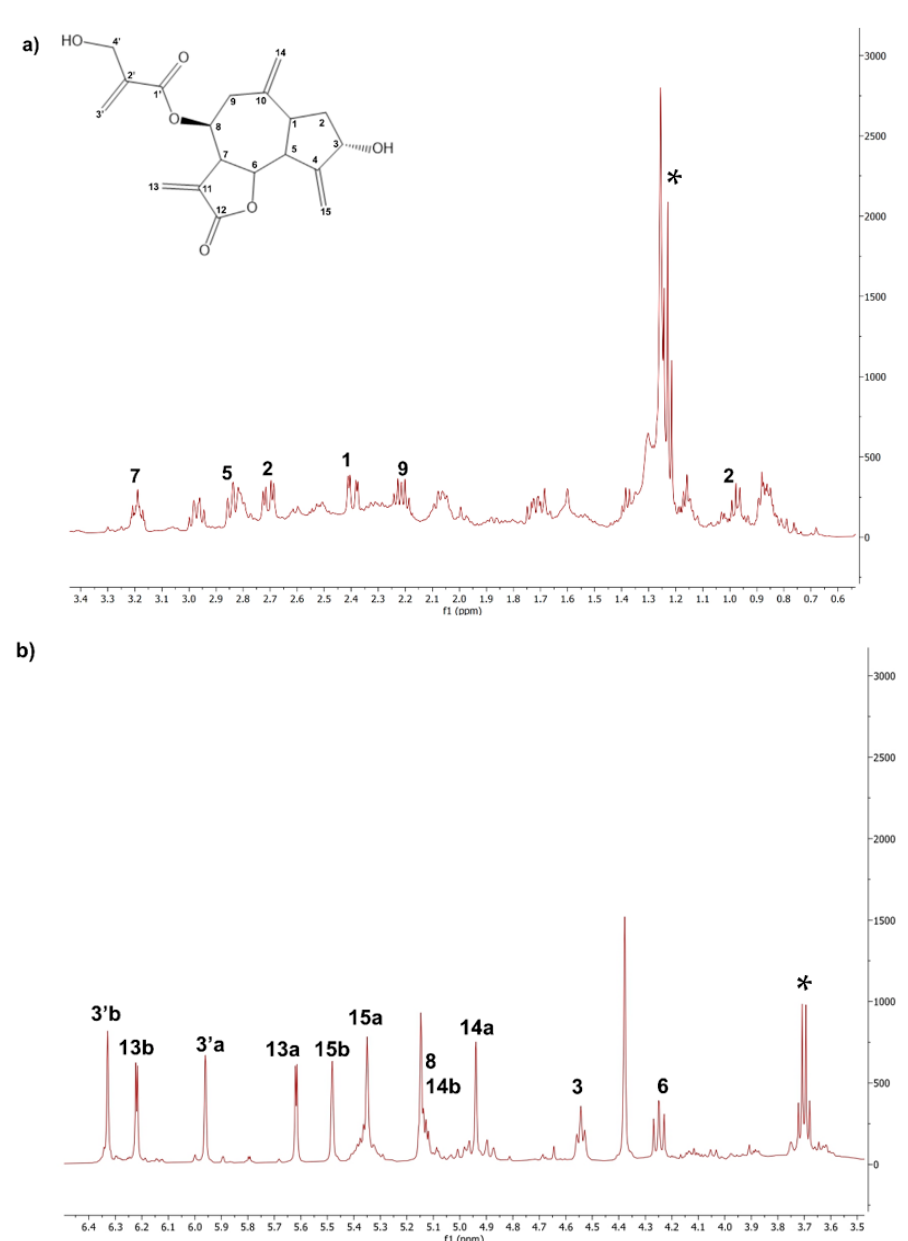
Figure 4. Details of the 1 H-NMR spectrum of the CLE NaviglioSp. ( a ) Signals of cynaropicrin in the range of 0–3.4 ppm; ( b ) Signals of cynaropicrin in the range of 3.5–6.5 ppm. 1 H-NMR (500